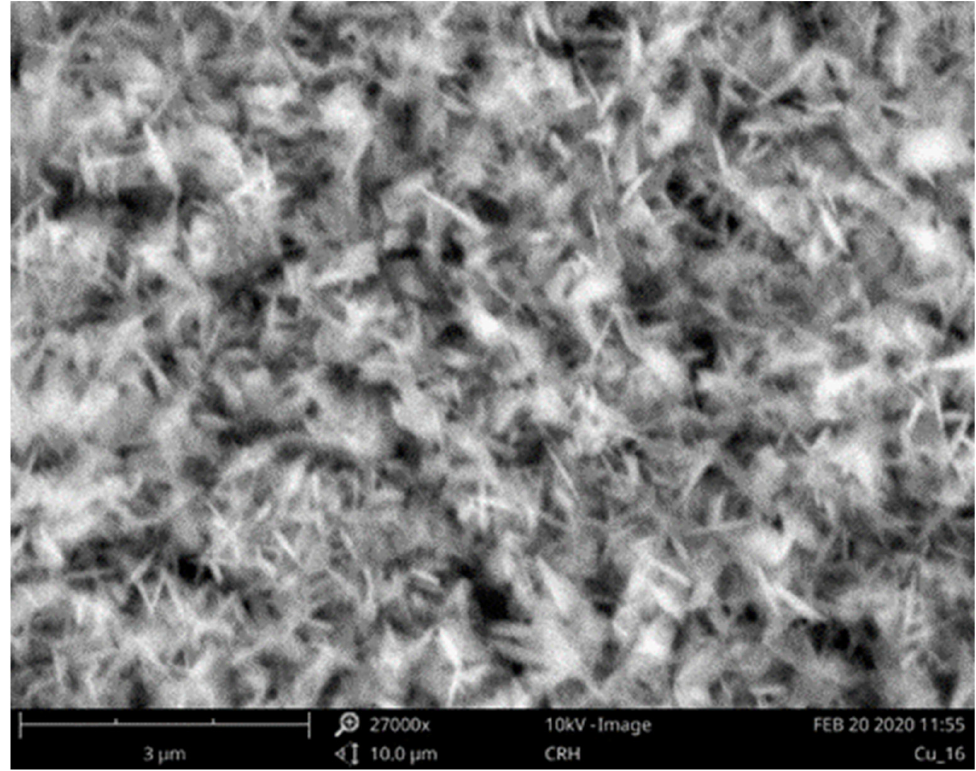
Figure 4. SEM-EDX picture of the Cu microstrip conductor.